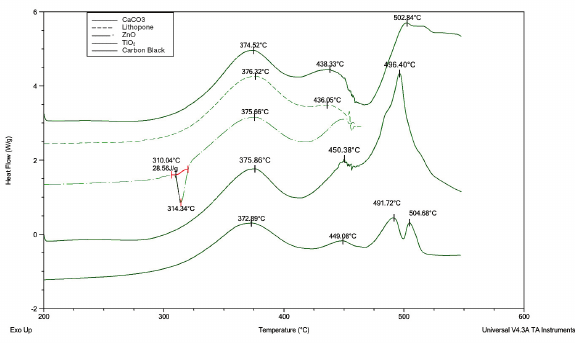
Figure 5: Thermal properties of polyurethane microcomposites with different mineral fillers studied. Curves (from top to bottom): CaCO Lithopone, ZnO, TiO and Carbon 2